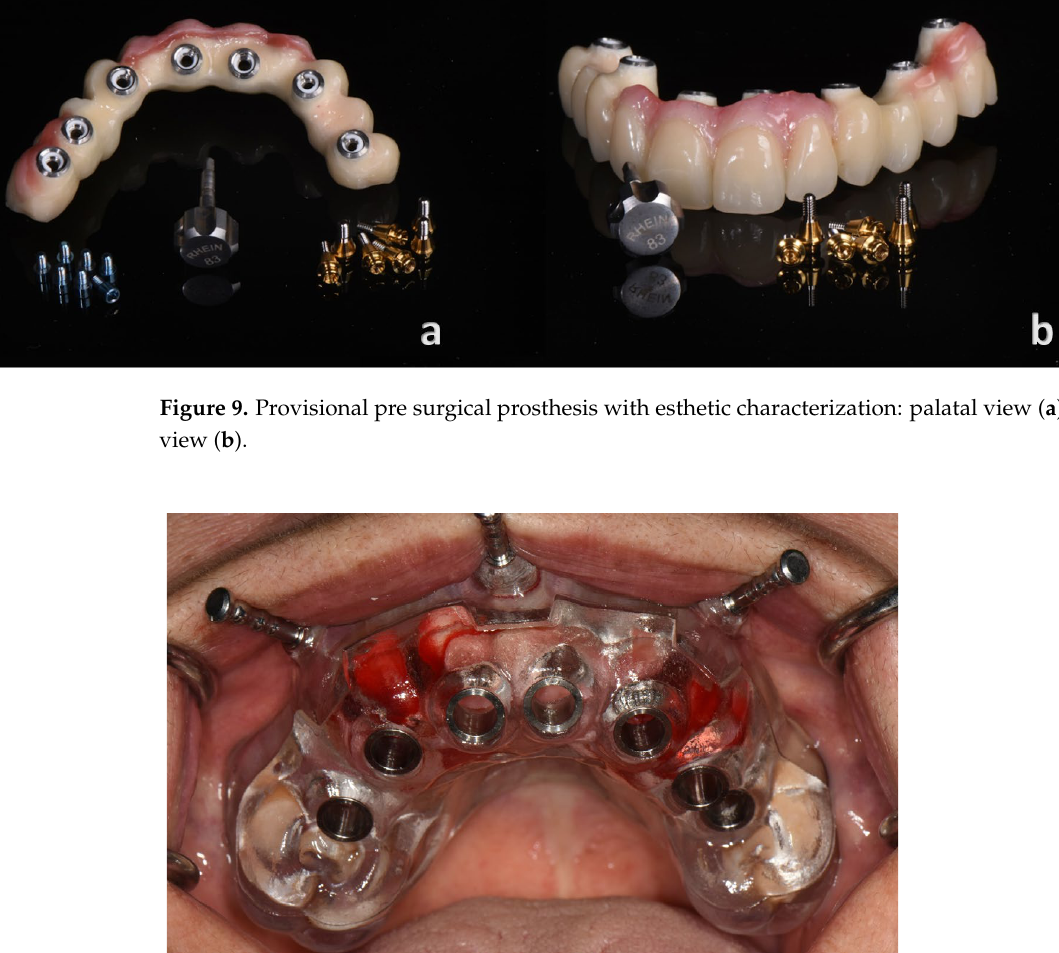
Figure 10. Surgical template correctly positioned in the upper jaw.